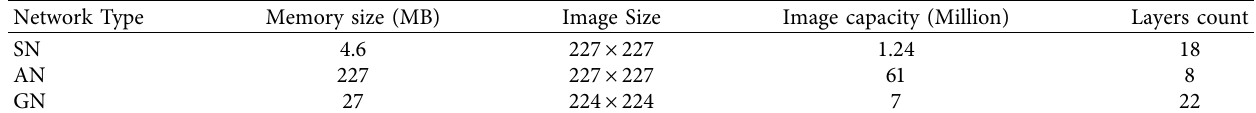
Table 6: Parameters of various neural